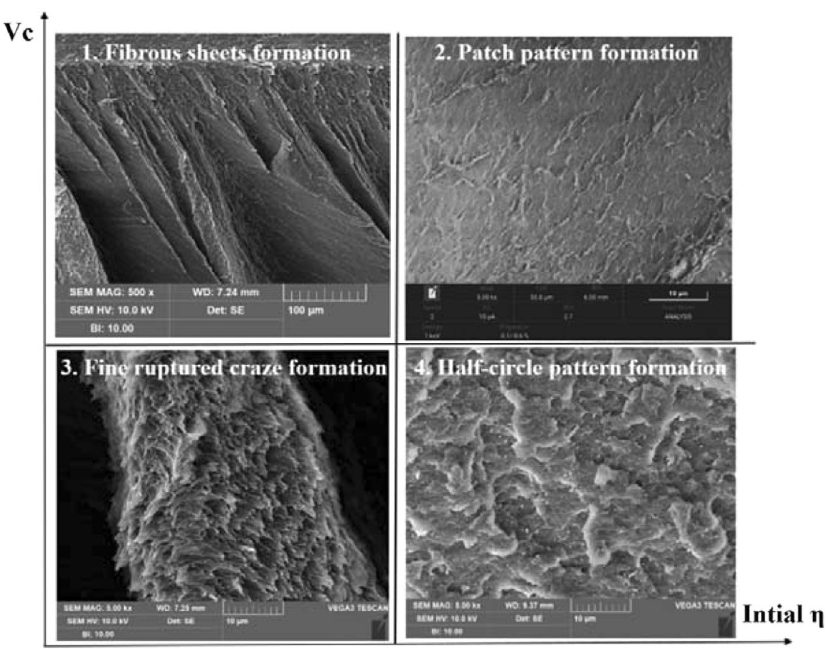
Figure 13. Proposed fracture pattern map of HIPS with abscissa as the initial stress triaxiality, η and ordinate as crack propagation speed, V c . (Note: type 1 is observed at ×500 and types 2–4 are all observed at same scale of ×5000 under